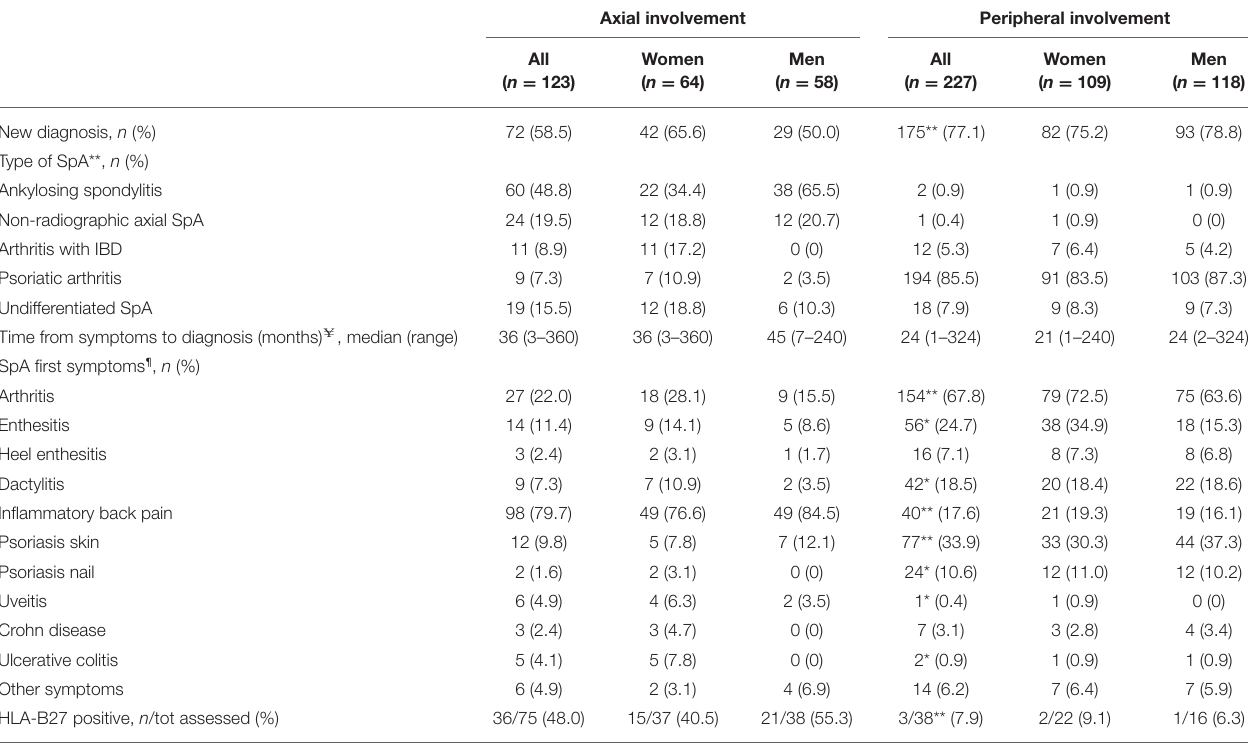
TABLE 3 | Baseline diagnostic features in 350 patients with SpA in the SIRENA study by involvement pattern and, in each subgroup, by gender ◦ .